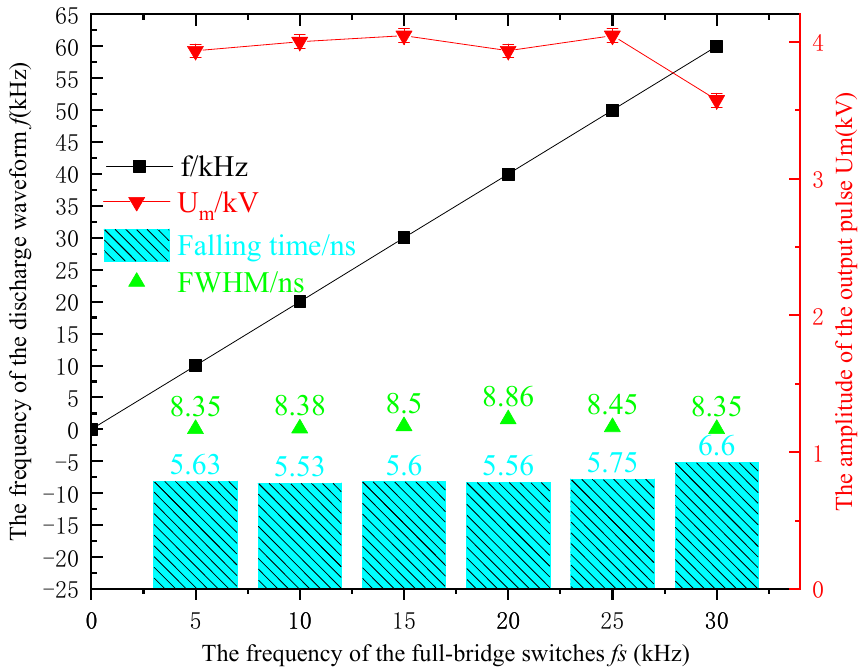
Appl. Sci. 2022 , 12 , x FOR PEER REVIEW Figure 12. The effect of switching frequency on discharge frequency and amplitude of the pulse.